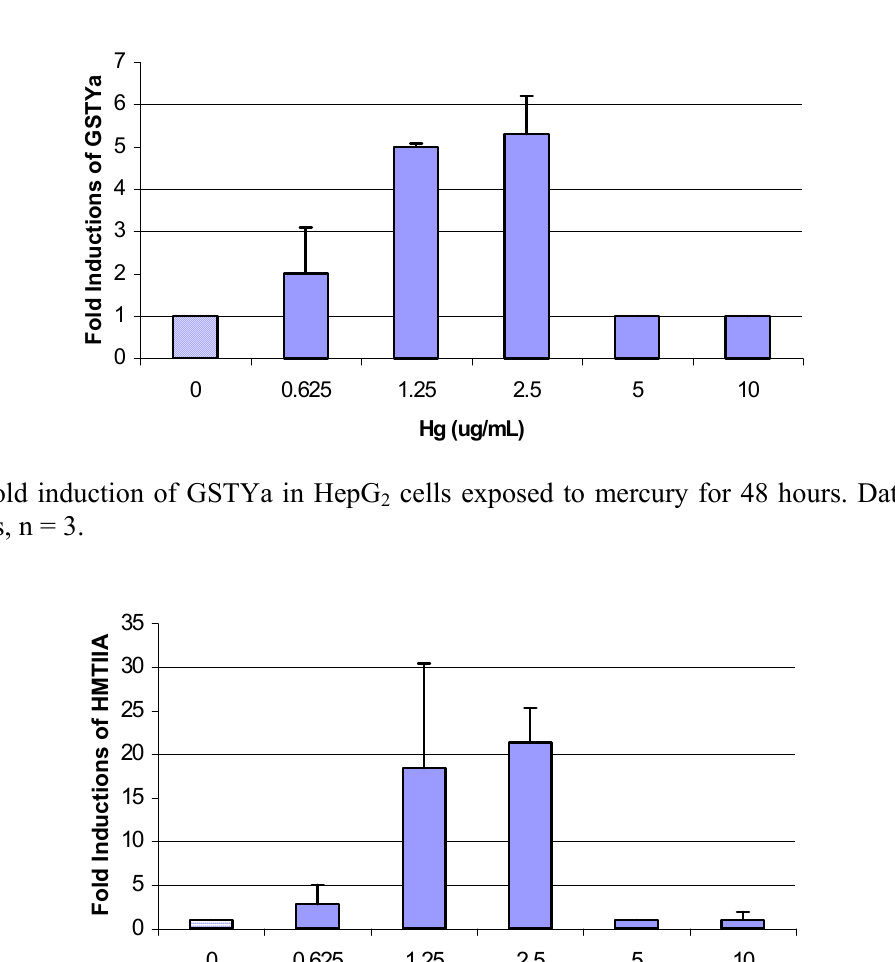
Figure 1. Cytotoxicity of HepG SDs, n = 3.